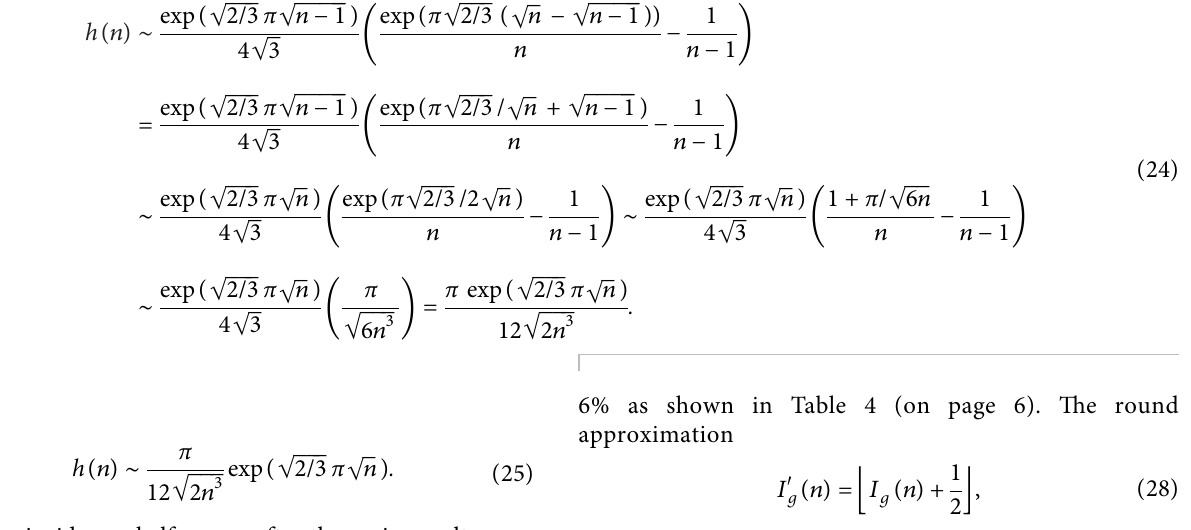
Figure 3: The graph of the data ( n, π exp ( π